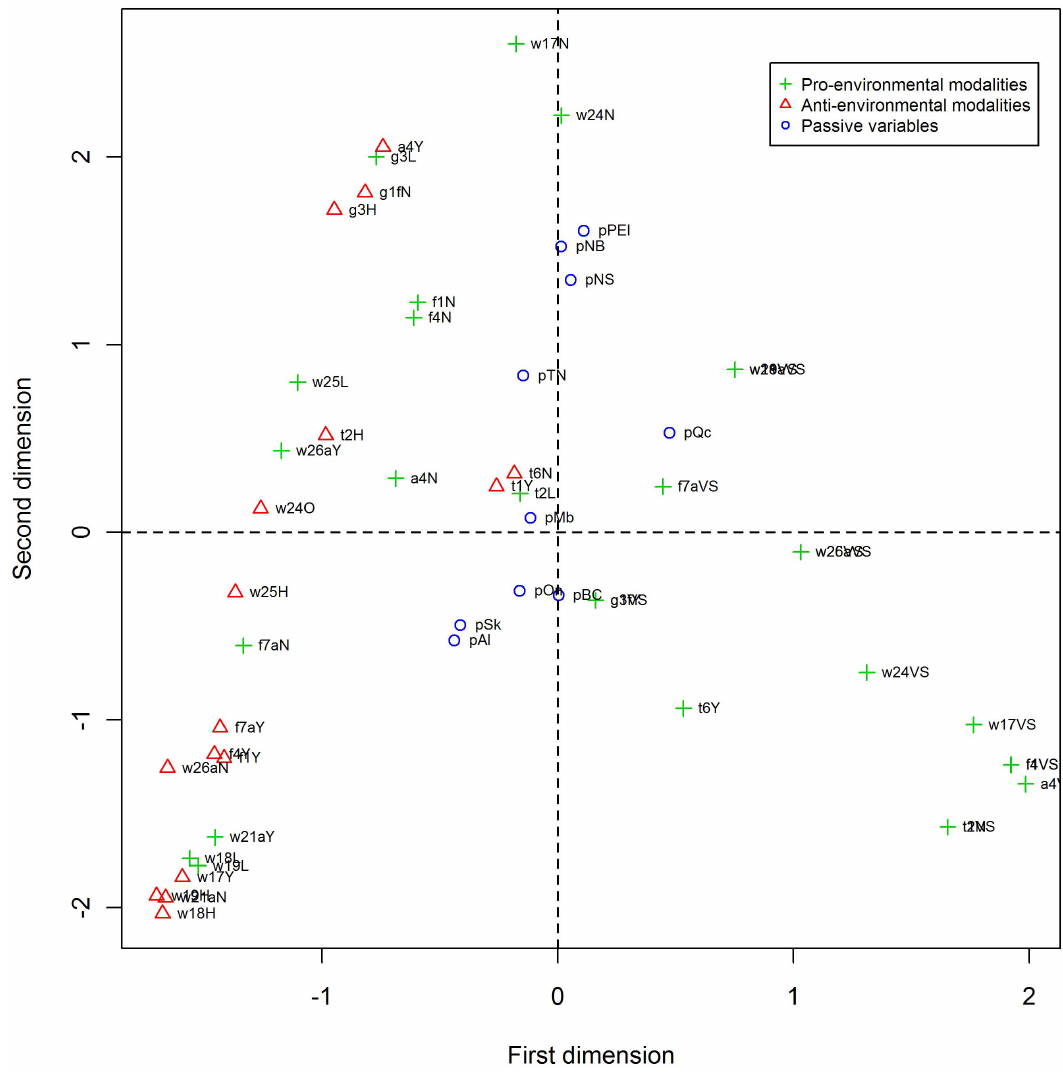
Figure 4. Map representation of the MCA results on the 16 questions of the group B (Outdoor).